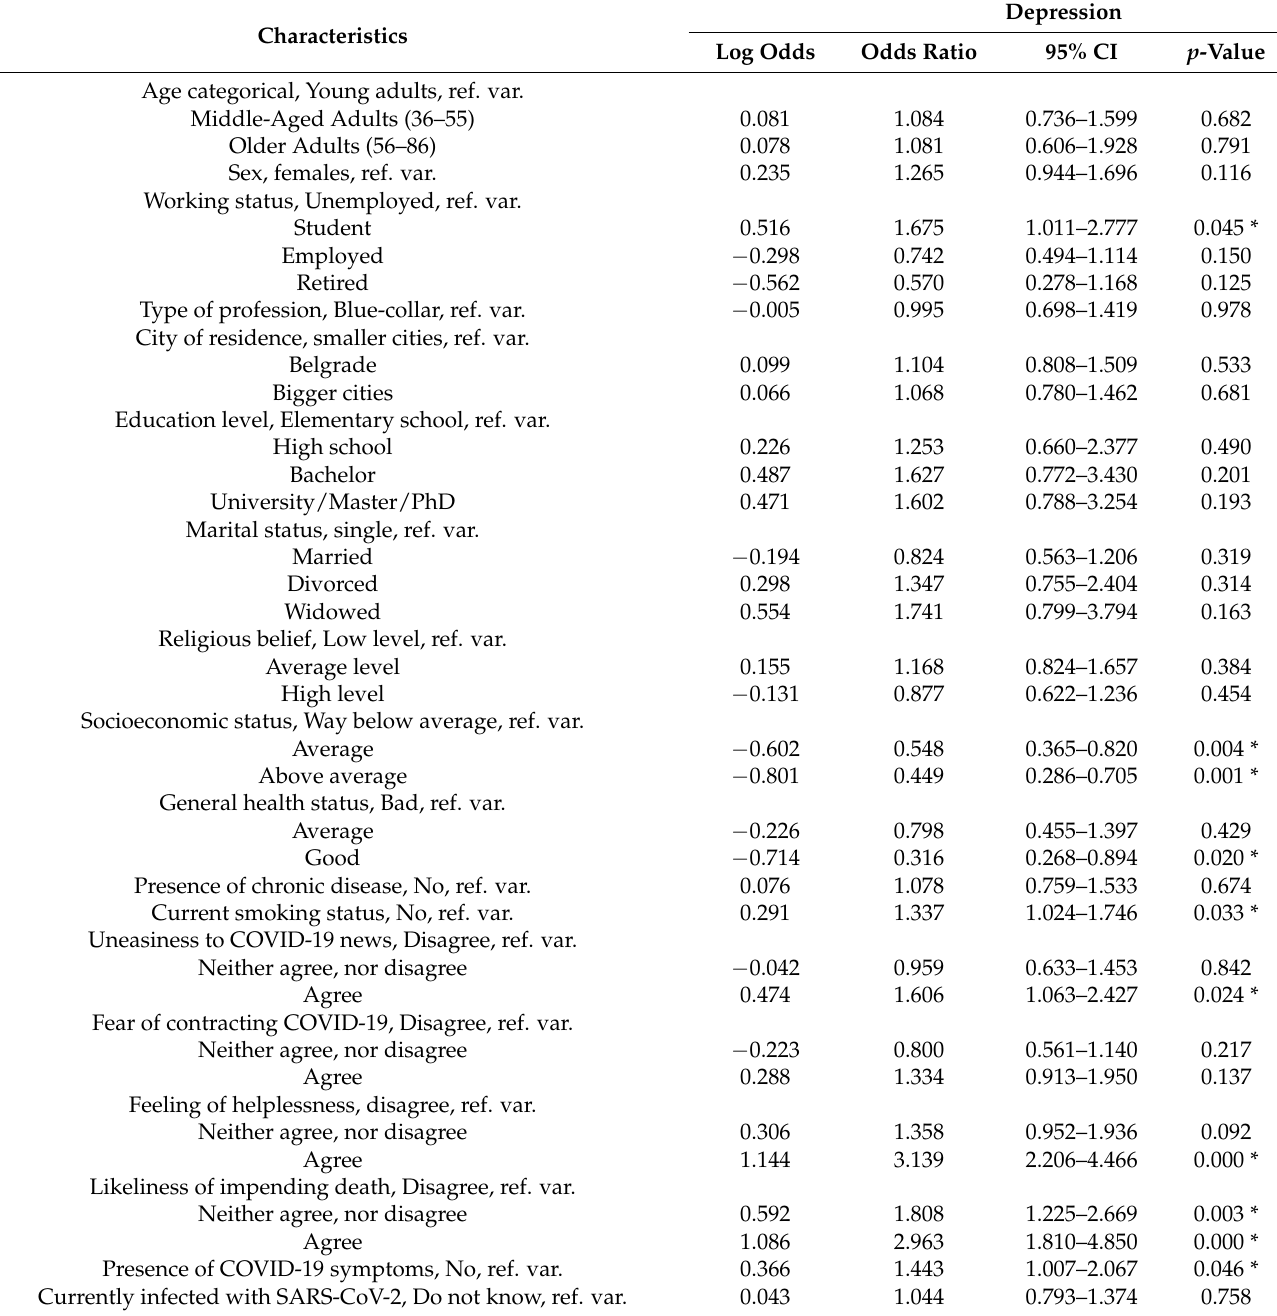
Table 4. Ordinal regression results for the depression